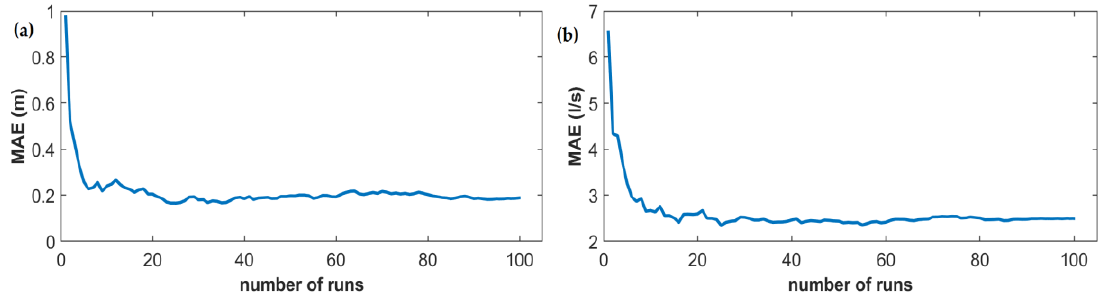
Figure 3. Behaviour of the Mean Absolute Errors (MAEs), calculated as the difference between average values and values of the reference network, of the distributed pressure driven (DPD) approach, with respect to the number of runs. In panel ( a ) is displayed the MAE related to the pressures and in panel ( b ) is displayed the MAE related to the flow rates.